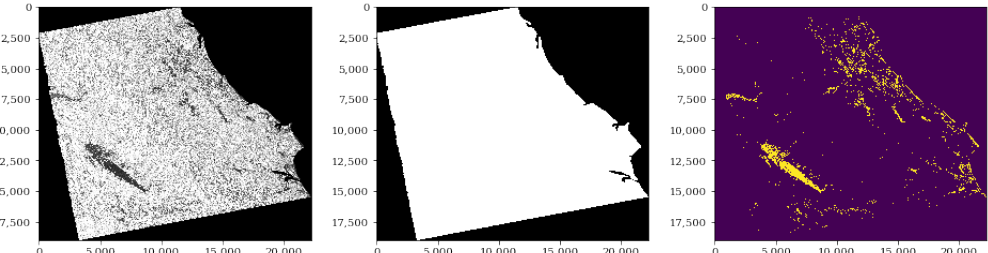
Figure 3. The analysis of Vietnam on the 6th September 2019 with the corresponding label. The left image displays the satellite imagery using the greyscale colormap. The dark region around the image on the left is the frame that comes with any image combined with the sea. The image in the middle shows the mask in white used to define the region of interest. The image on the right shows the water label in yellow using the viridis colormap.